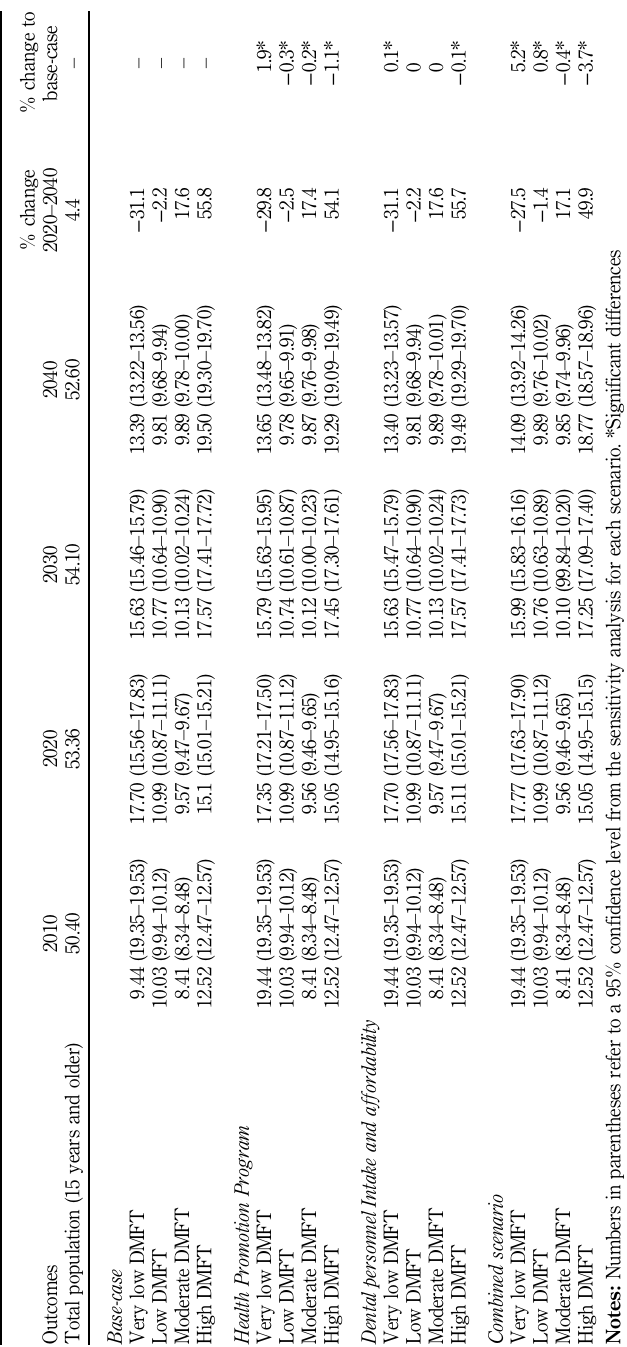
Table I. Projected numbers of population by dental caries status